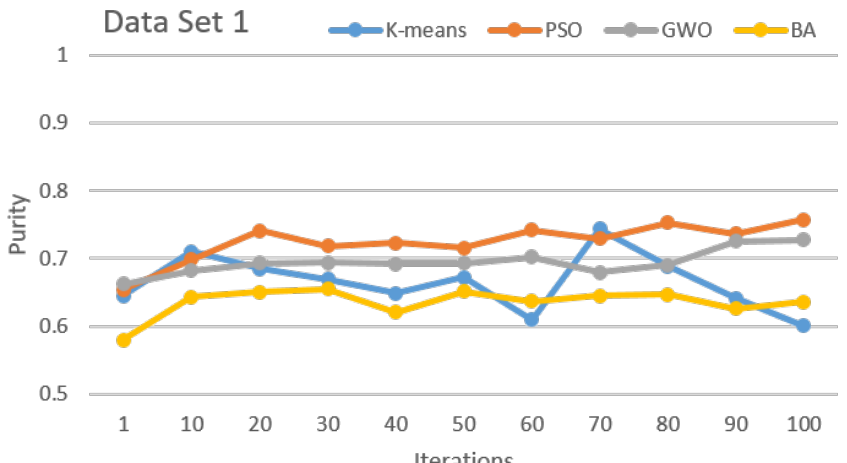
Figure 2. Purity comparison for data set 1.